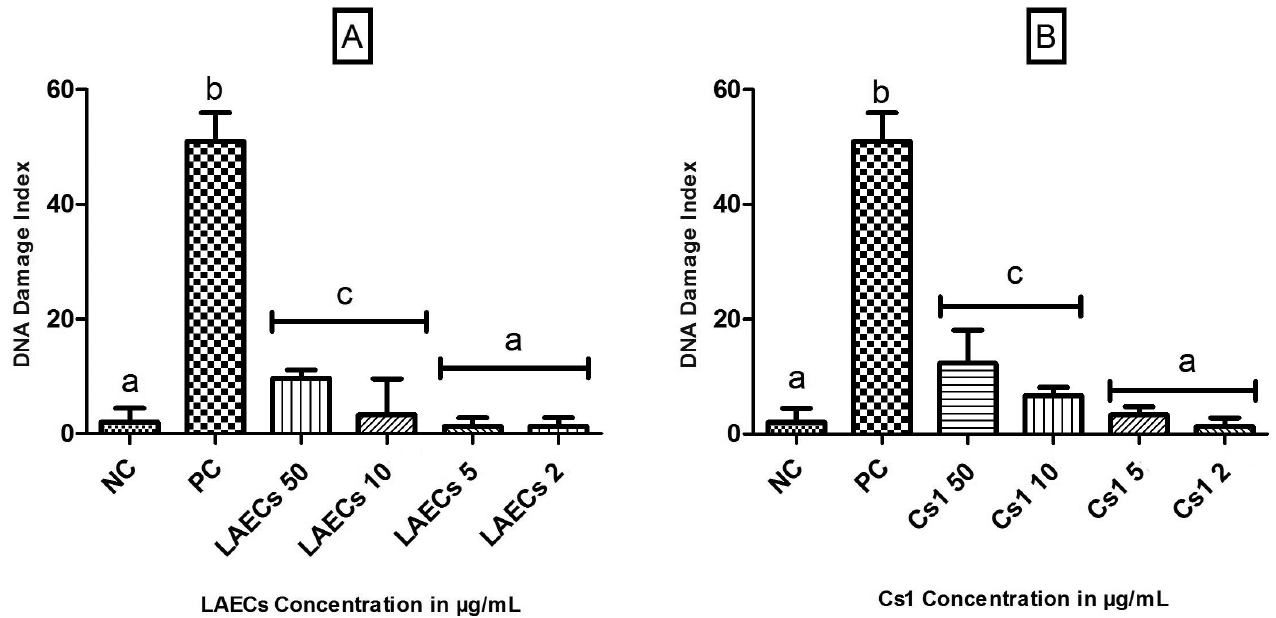
FIGURE 6 - Effects of lyophilized aqueous extract (LAECs) and raw ethanol extract (Cs1) in Comet assay of human leukocytes. NC – Negative Control ( phosphate buffered saline, PBS ); PC – Positive Control; (H 2 µg/mL); (B) Cs1 (50, 10, 5 and 2 µg/mL). Data are expressed as mean ± SD. Columns with different letters are significantly different